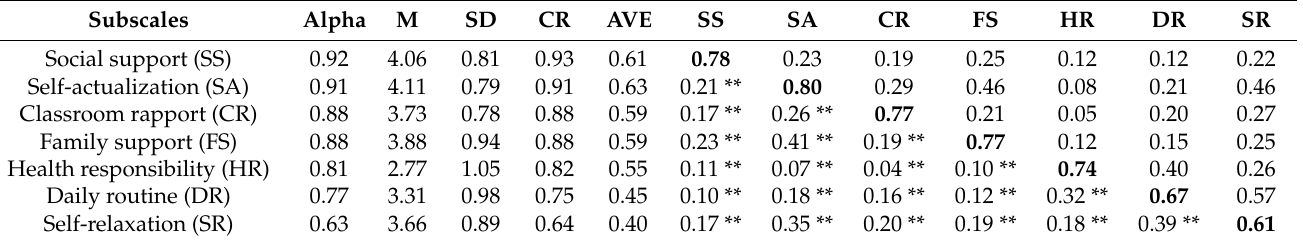
Table 2. Descriptive statistics, intercorrelations, reliabilities, and validities for the coping